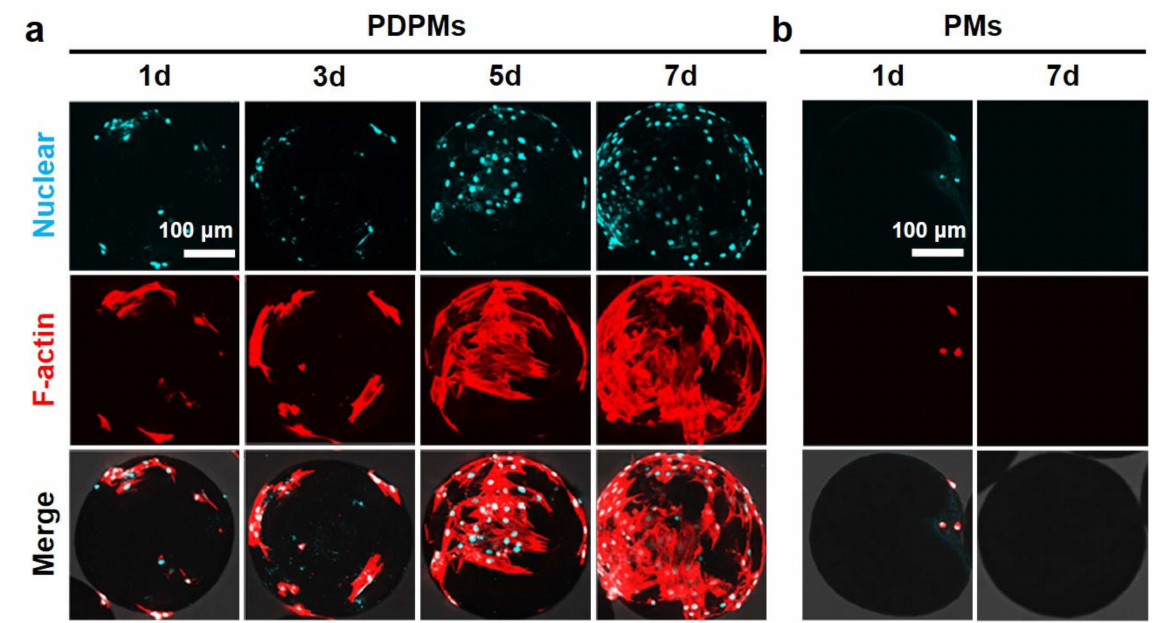
Figure 8. ( a ) Cell adhesion on PDA-modified PCL porous microspheres (PDPMs); ( b ) cell adhesion on PDA-free microspheres (PMs). (Scale bar is for all results in ( a , b )).